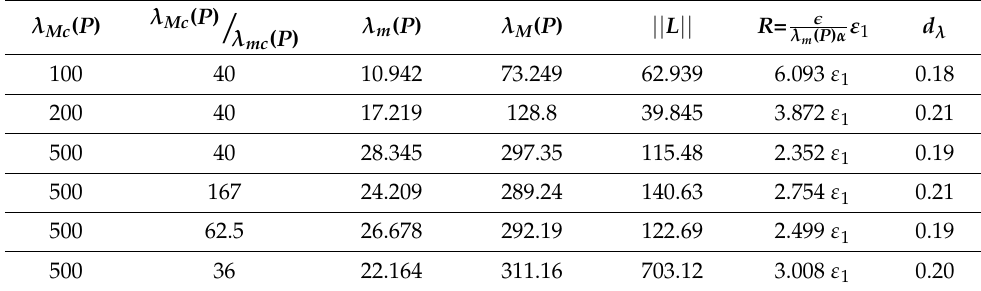
Table 3. Impact of the constraints imposed on the eigenvalues of P on || L || and R for (cid:101) = 100, α = 3.